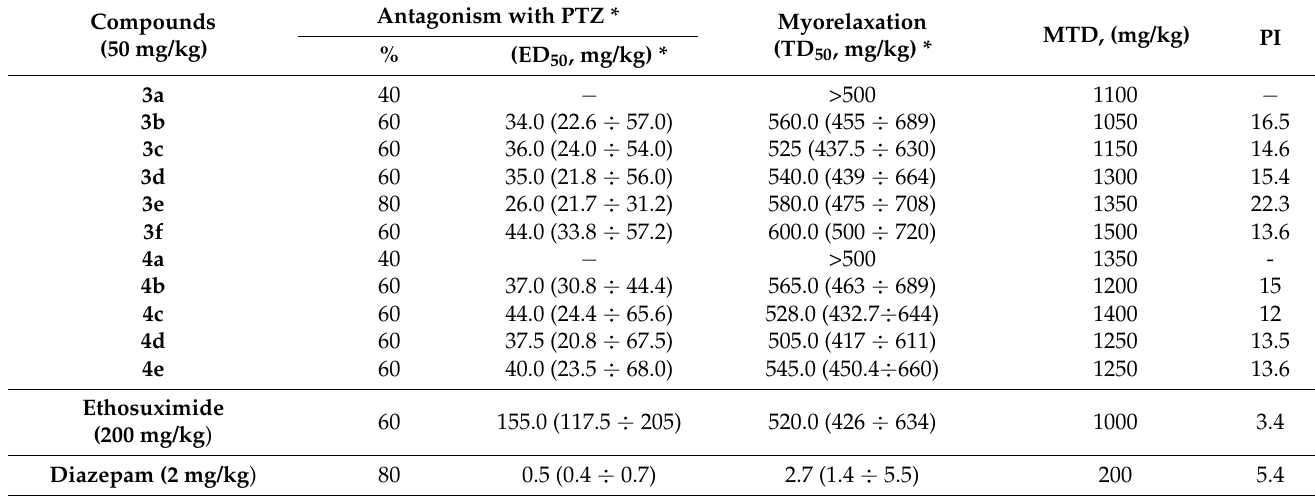
Table 3. Anticonvulsant activity by pentylentetrazol antagonism, myorelaxation and maximal tolerated doses (MTD) of the examined all compounds (intraperitoneal injection).